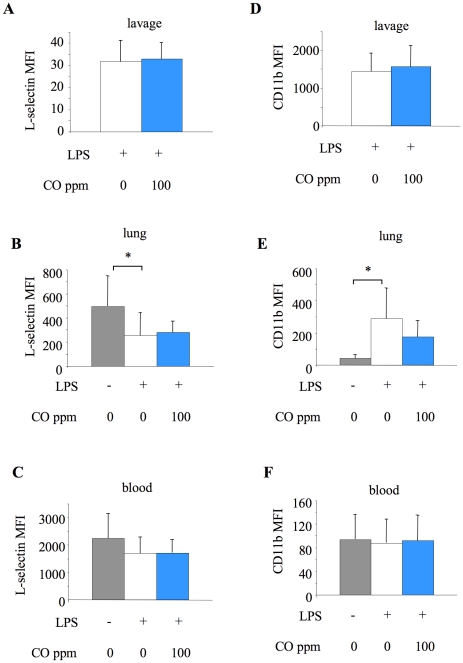
Neutrophil adhesion molecule expression, determined by flow cytometry.Surface expression of L-selectin (A–C) and CD11b (D–F) on neutrophils from lavage (A,D), lung tissue (B,E) and blood (C,F) from untreated animals (no LPS or CO), or mice exposed to 0 or 100 ppm carbon monoxide (CO) for 6 hours after LPS instillation. Data are expressed as mean fluorescence intensity (MFI). The data of lavage neutrophils in untreated animals were not included because the numbers of cells recovered were too small to allow for accurate analysis. *p<0.05 vs LPS +0 ppm CO; n = 9–10/group.